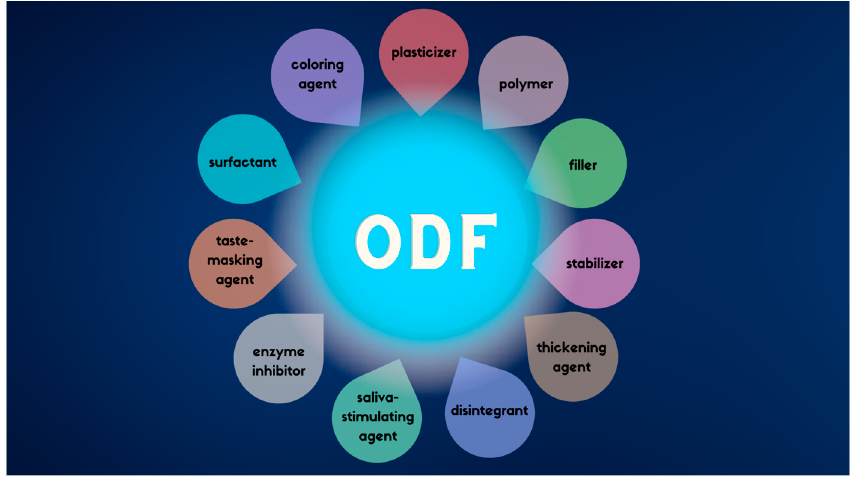
Figure 1. Excipients used in formulation of ODFs [33].